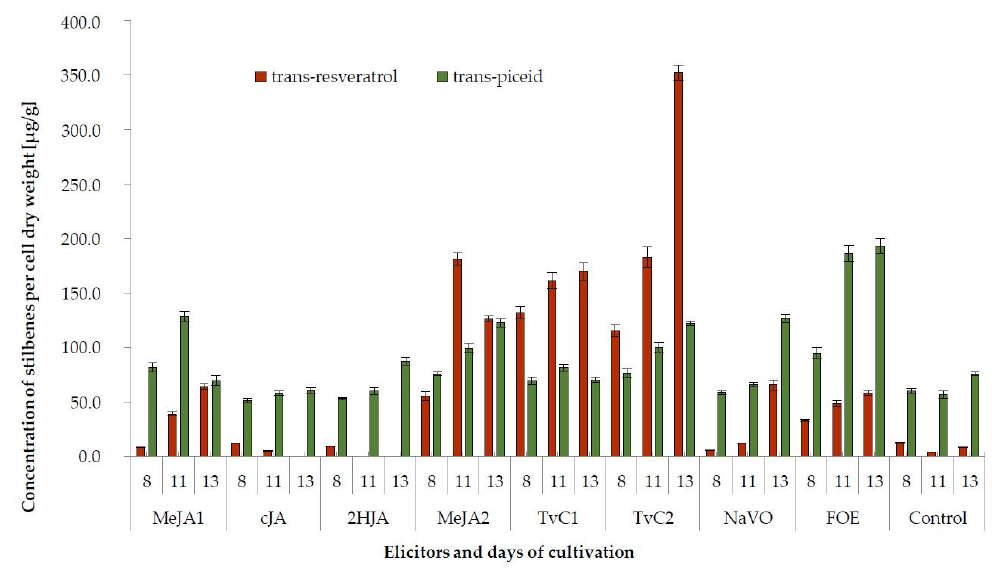
Figure 3. Production of trans -resveratrol and trans -piceid in control and elicited grapevine cell suspension cultures on the 8th, 11th, and 13th day of cultivation, that is, 2, 5, and 7 days after elicitation, respectively.